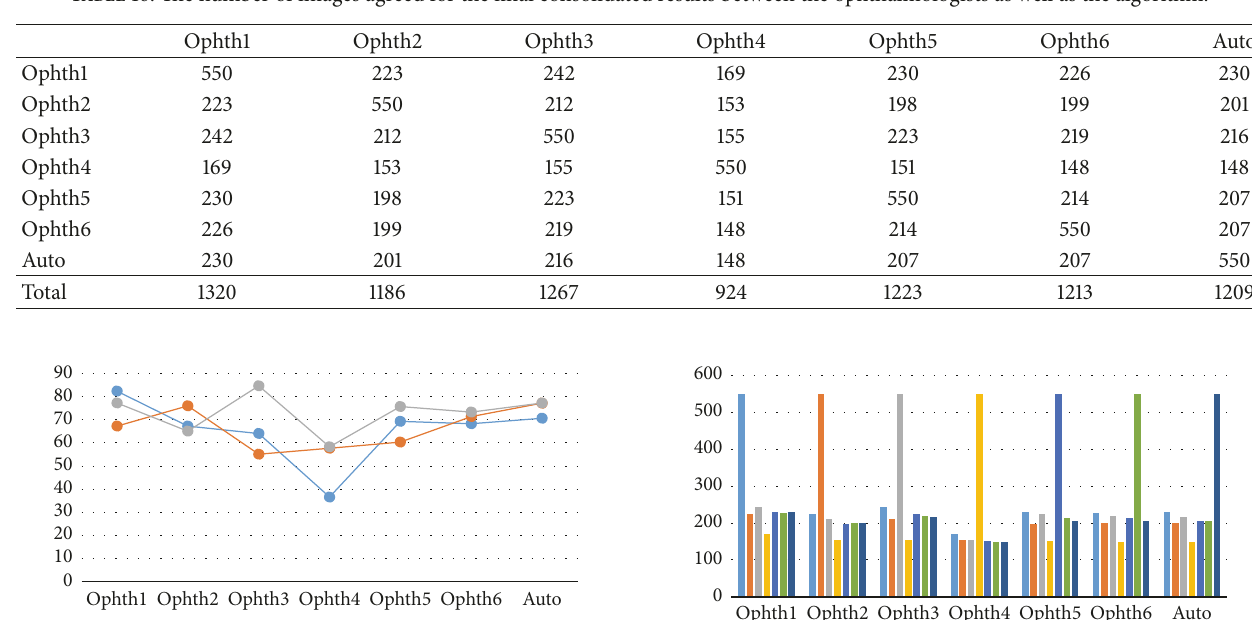
Table 16: The number of images agreed for the final consolidated results between the ophthalmologists as well as the algorithm.